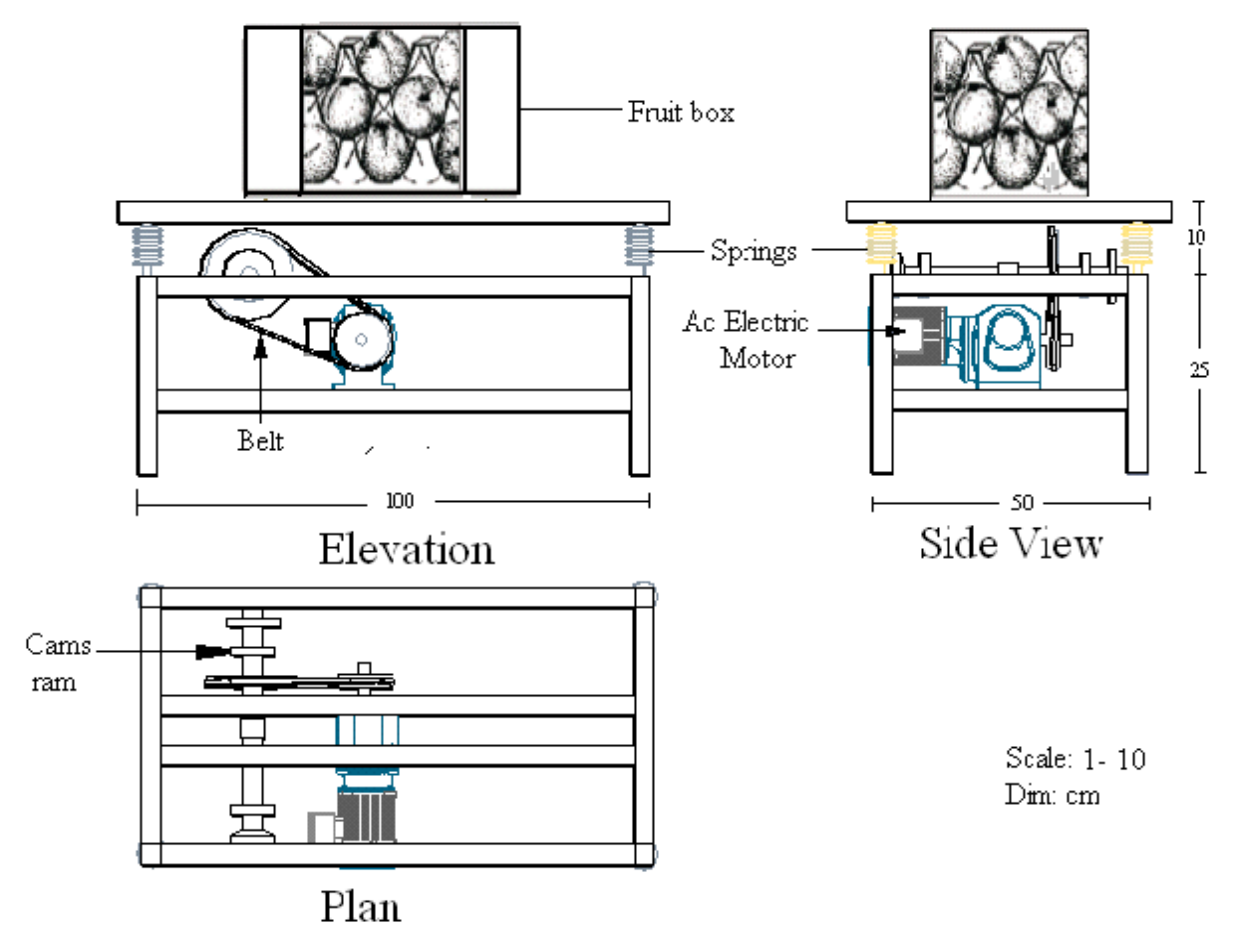
Figure 5. Schematic diagram of a laboratory vibration simulator.